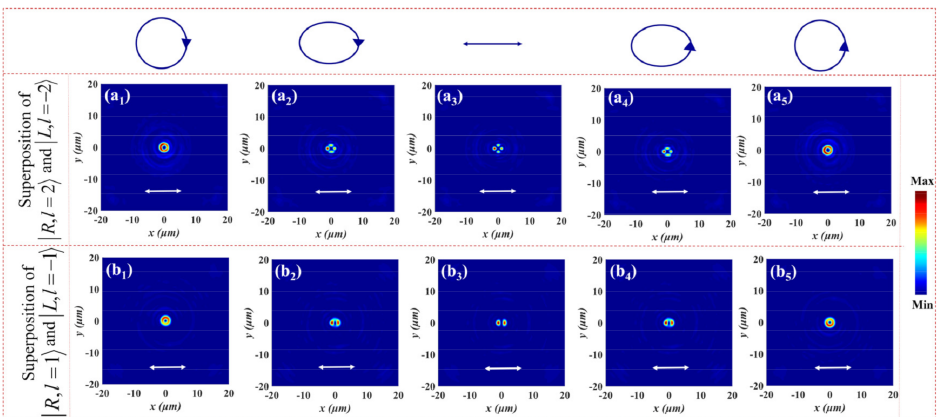
Figure 8. The electric field intensity profiles of generated beams corresponding to five po-larized states of the HyOPS after transmission through a horizontal linear polarizer at different focal planes for ( a 1 , b 1 ) LCP, ( a 2 , b 2 ) LEP, ( a 3 , b 3 ) XLP, ( a 4 , b 4 ) REP, and ( a 5 , b 5 ) RCP illumination. The analyzing polarizer is depicted by the white double